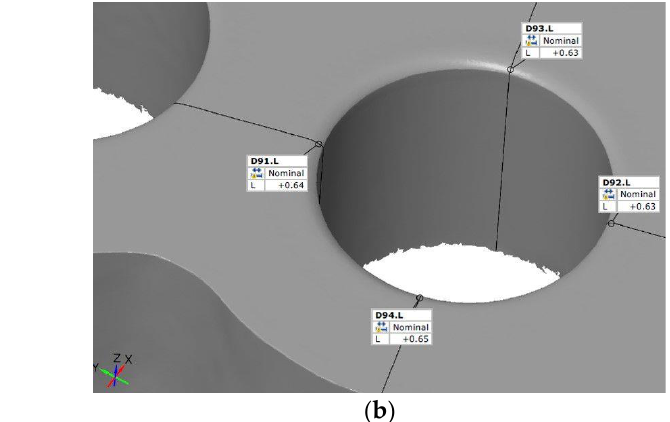
Figure 20. Deburred ADT gearbox housing: ( a ) block section; ( b ) measuring the repeatability of the radius.